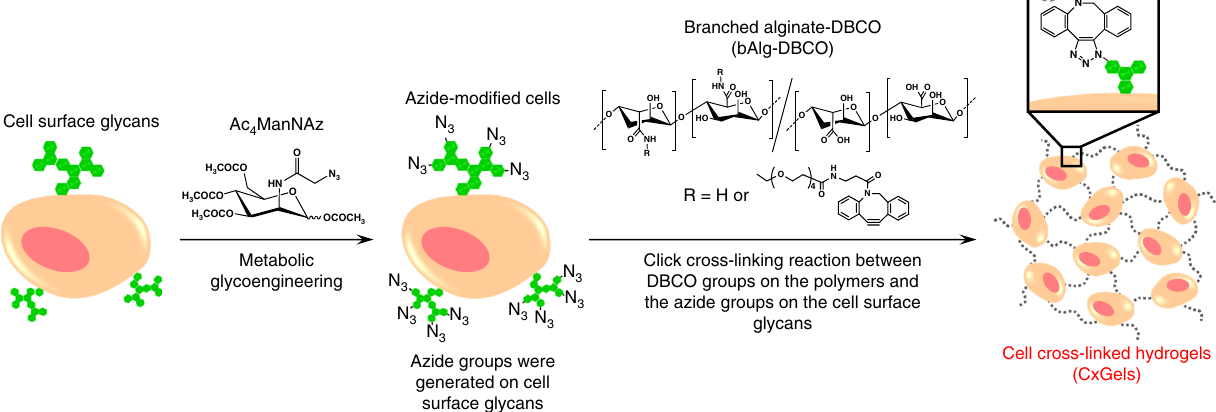
Fig. 1 Schematic illustration of the construction of cell cross-linked hydrogels (CxGels). Reactive azide groups are covalently incorporated into cell-surface glycans through the biosynthetic machinery. CxGels are constructed via bioorthogonal click cross-linking reaction between the azide-modi fi ed cells and the alkyne-modi fi ed